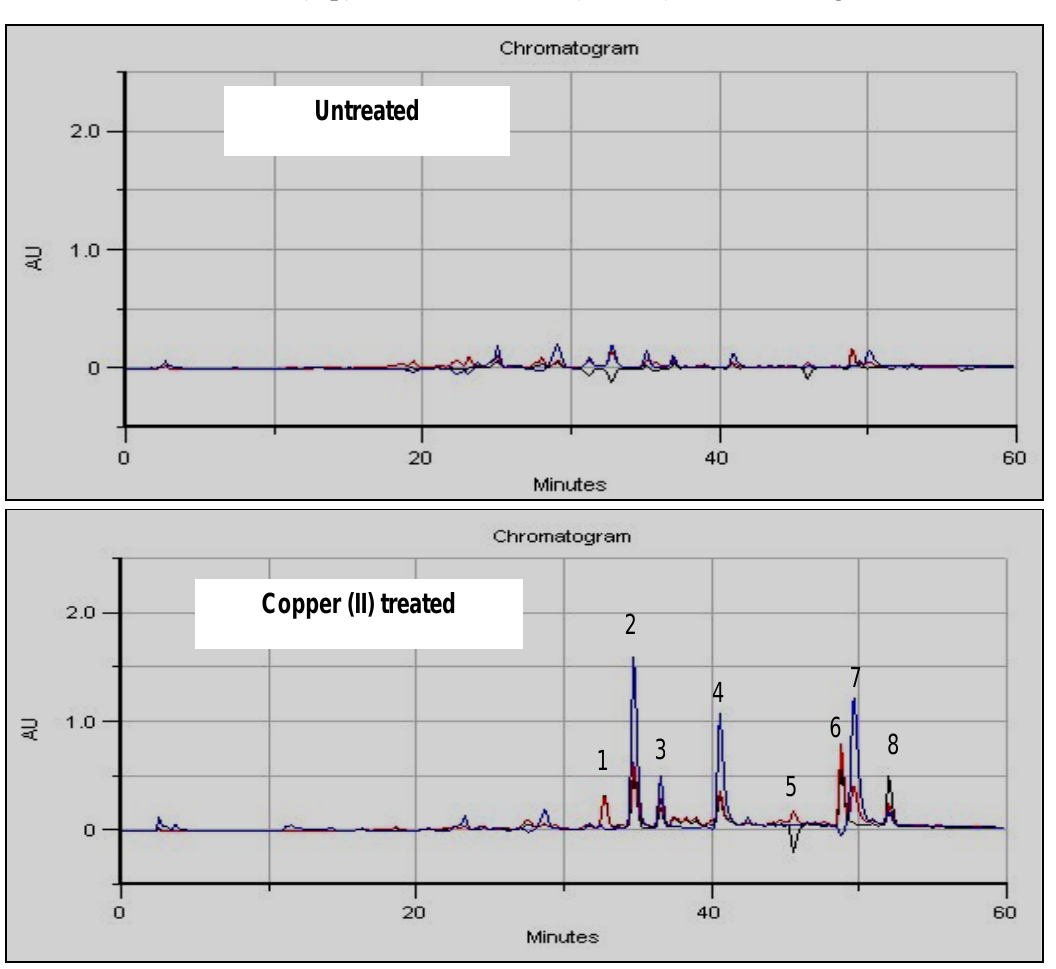
in the elicitation of phytoalexins 2